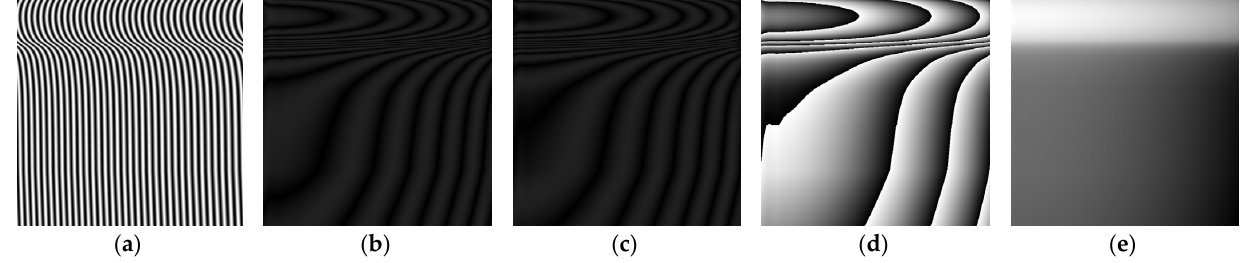
Figure 10. Simulation process of wheel tread reconstruction. ( a ) deformed fringe; ( b ) moire fringe pattern 1; ( c ) moire fringe pattern 2; ( d ) wrapped phase; ( e ) continuous phase.